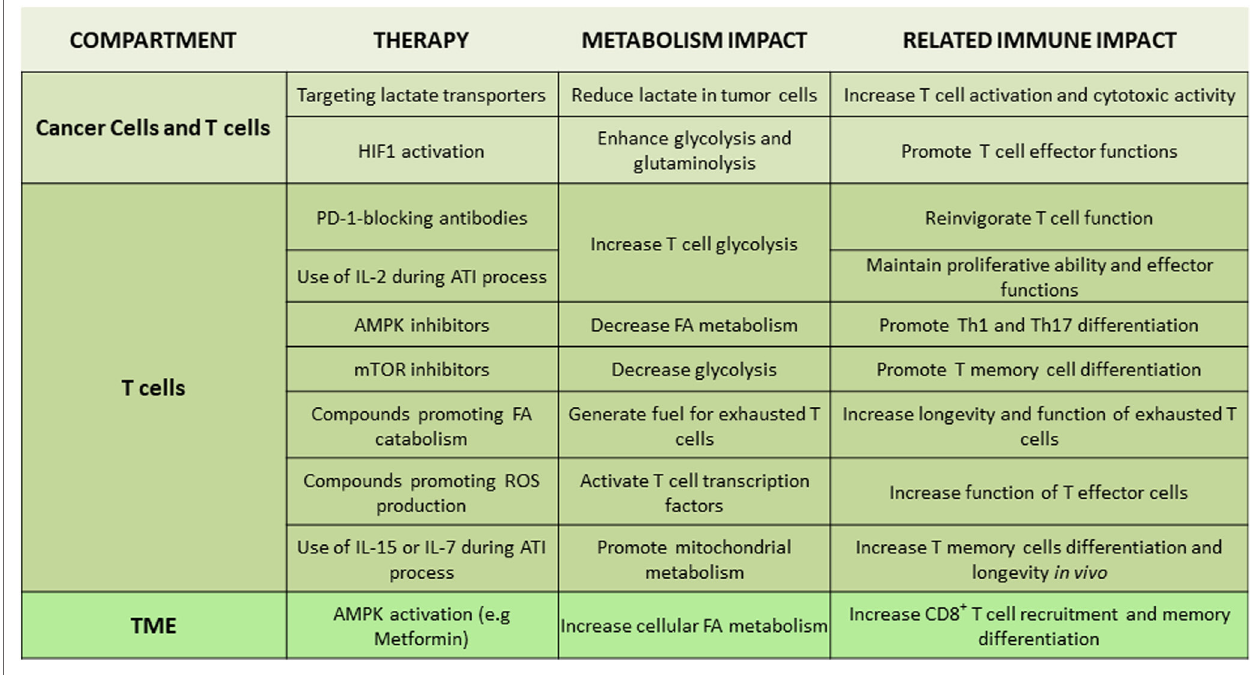
FiGURe 4 | Tentative therapeutic targets for integration of metabolism and immunotherapy. Non-exhaustive representation of potential therapies to integrate metabolism in immunotherapy, description of the metabolism impact, and the related immune impact for each targeted therapy. Abbreviations: AMPK, AMP- activated protein kinase; ATI, adoptive T cell immunotherapy; FA, fatty acid; HIF1, hypoxia-inducible factor-1; IL-2/7/15, interleukin-2/7/15; Th, T helper cells; TME, tumor